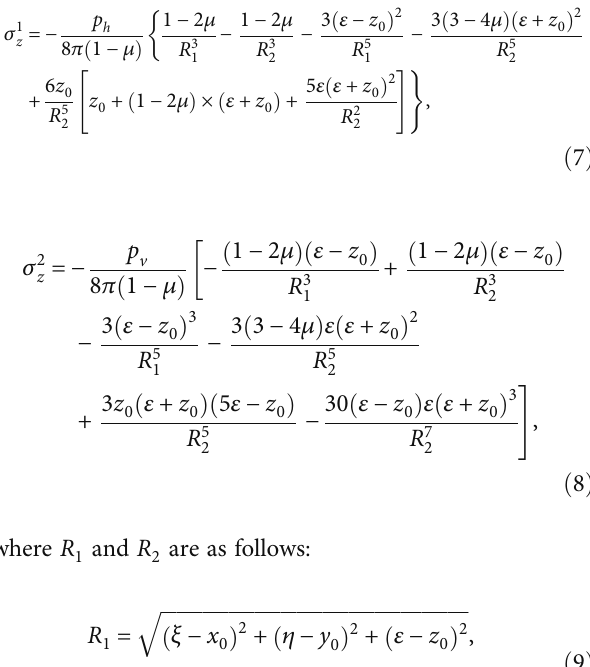
4.3. Additional Stress Induced by Shield Friction. While shield tunneling, the friction force generated by contact between the shield and the surrounding stratum will a ff ect the displacement of the stratum. The calculation diagram of additional stress induced by friction of shield shell is shown in Figure 5, where s is the horizontal distance between the integral unit and the cutter and L is the length of shield. Taking any unit dA = R dsd θ on the two semicir- 1 1 = fR dsd θ . cles, the shield friction force on the unit is dF 1 f 1 = dxdy in the rectangular part, the Taking any unit dA 2 = fdxdy . Substitute shield friction force on the unit is dF f 2 into Equation (8) and integrate within the shield shell dF fi range to obtain the vertical additional stress induced by at axis of existing shield tunnel. shield shell friction force σ 1 2 f The element coordinates need to be transformed during the